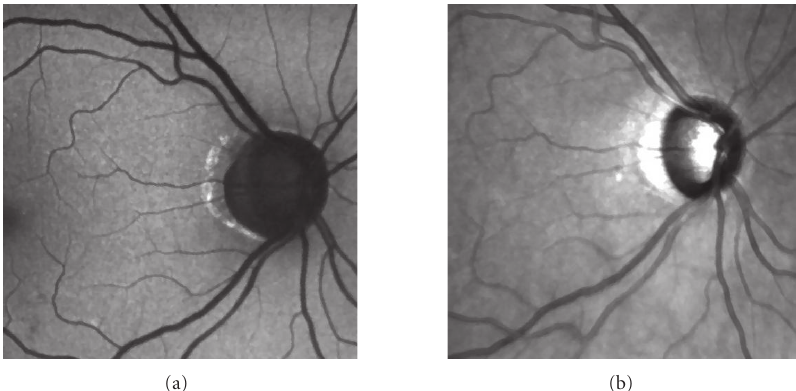
Figure 3: E ff ect of anisotropic di ff usion filtering on (a) AF and (b) IR images. The corresponding images are on Figure 1. The parameters of anisotropic di ff usion were set to κ = 1 . 5, t = 0 . 125, and iteration = 10.